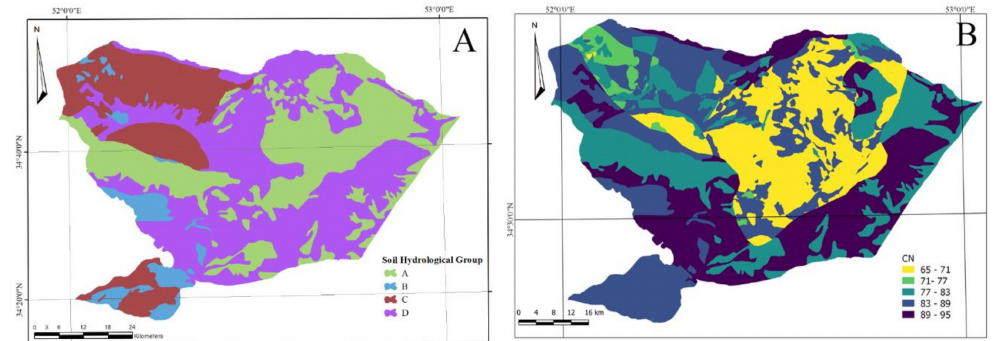
Figure 8. Soil texture map of the study area.